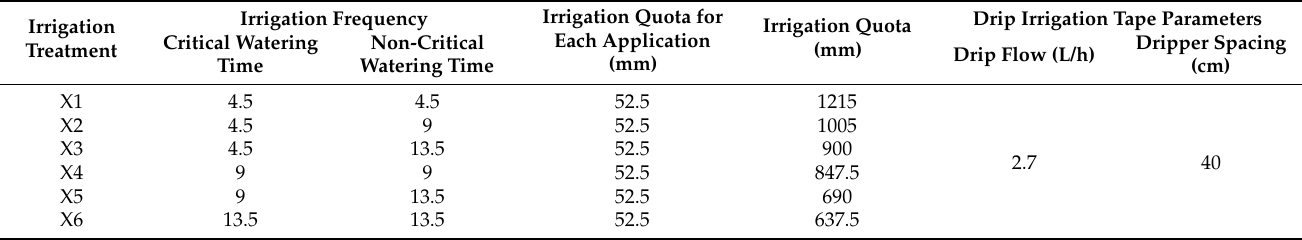
Table 1. The design of the irrigation experiments.